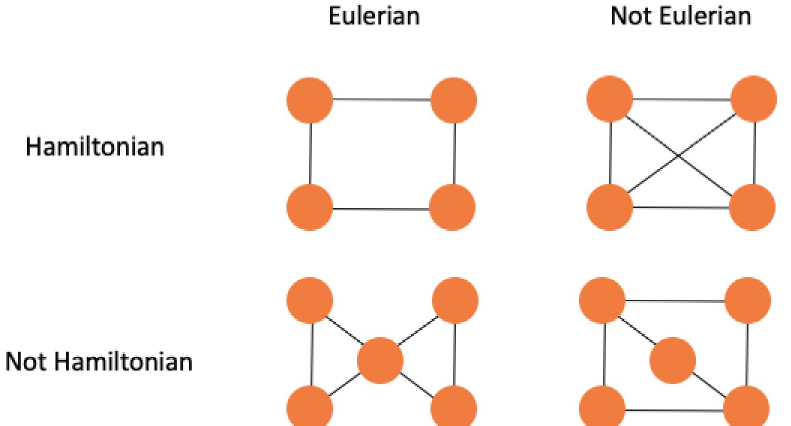
Fig 6. Example of Hamiltonian and Eulerian